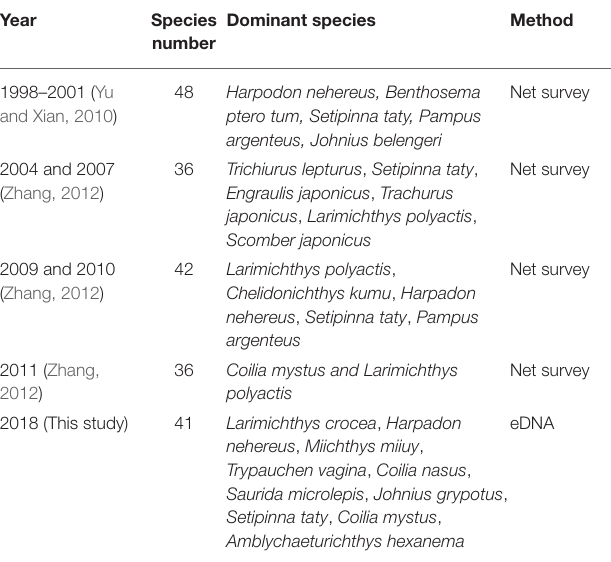
TABLE 5 | Species composition in different